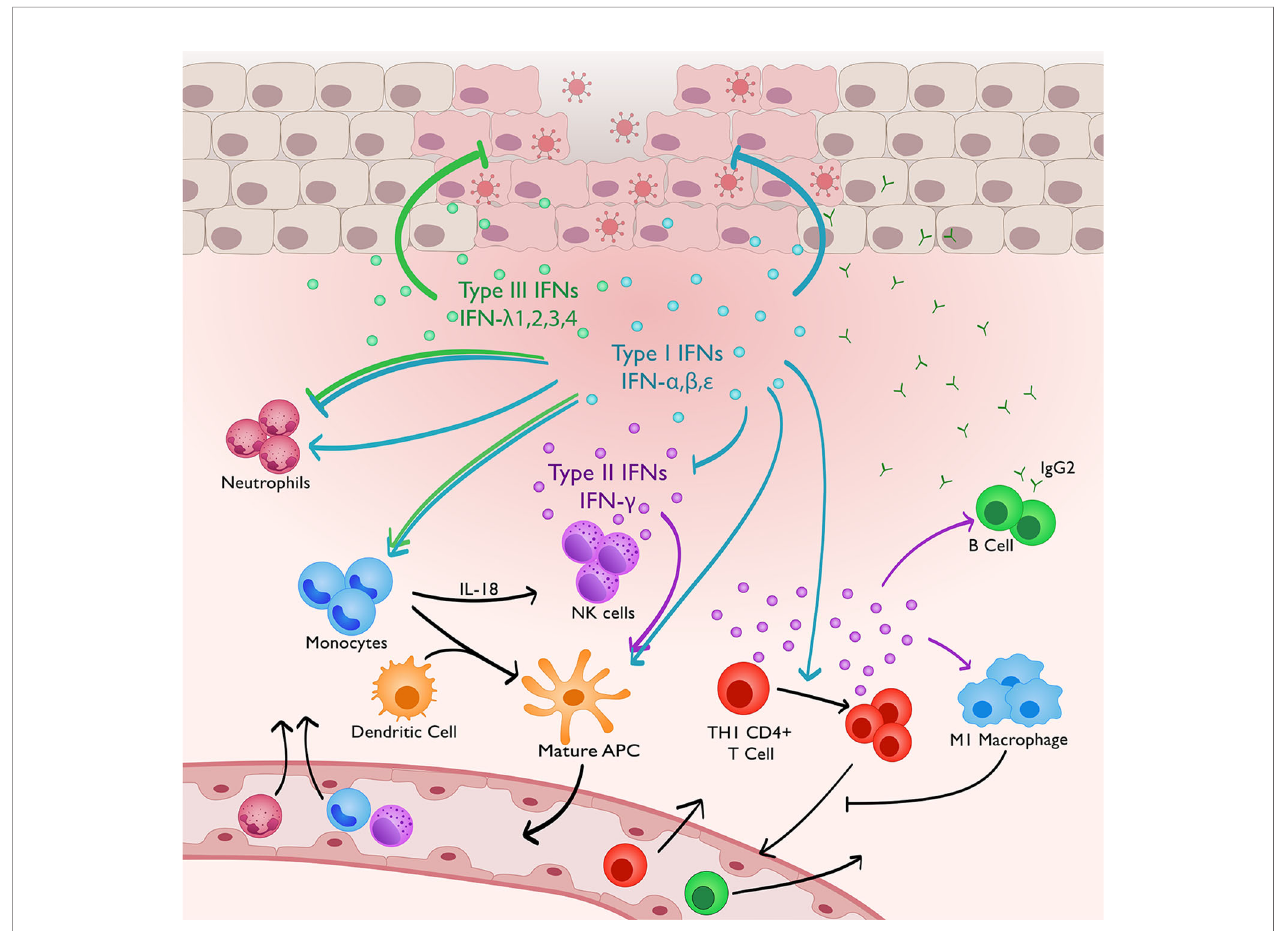
FIGURE 1 | IFNs regulating innate and adaptive immunity to genital HSV-2 infection. Type I and III IFNs directly suppress HSV-2 replication in the genital mucosa. Concurrently, type I IFN signaling promotes IM recruitment and production of IL-18. This in turns stimulates NK cell IFN- g production. Type I IFNs stimulate adaptive immunity both directly and indirectly through IM differentiation into APCs, maturation of DCs, and inducing CD4+ T cell expansion. Type I IFNs can both promote neutrophil function, and negatively regulate innate immune responses to prevent immune-mediated pathology by suppressing neutrophil recruitment and limiting IFN- g production by NK cells. IFN- g production, highly dependent on type I IFN signaling, promotes IgG2 antibody production, M1 macrophage polarisation and DC maturation, which will promote CD4+ memory T cell retention via production of CCL4 and CXCL9. Type III IFNs, similar to type I IFNs, have also been shown to suppress neutrophil activity and monocyte-mediated NK cell activation, but this is not yet demonstrated in the vaginal